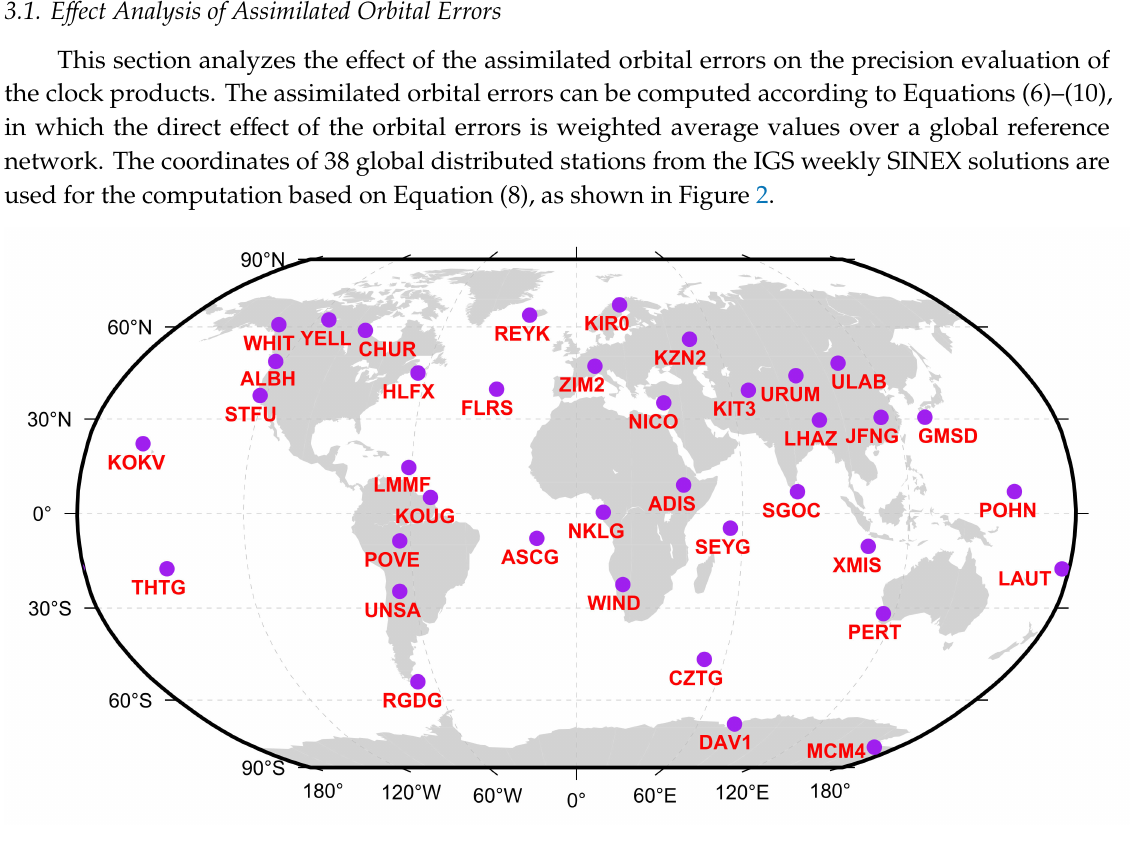
Figure 2. Distribution of stations used to compute the assimilated orbital